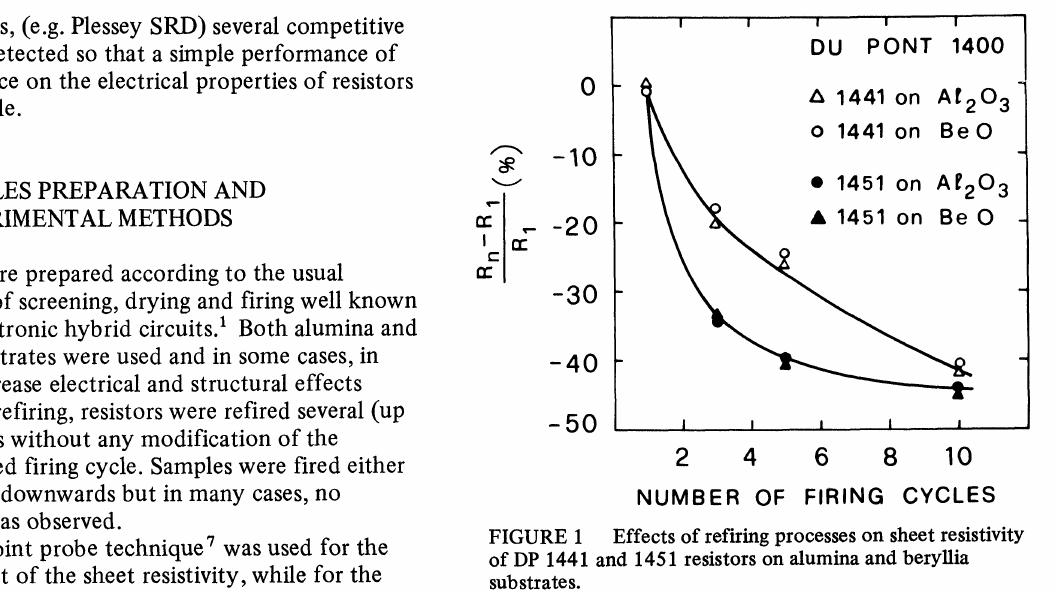
NUMBER OF FIRING CYCLES